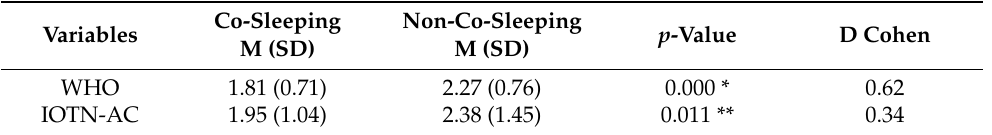
Table 4. Comparison of clinical variables of malocclusion (IOTN-AC and WHO) in co-sleeping ( n = 130) and non-co-sleeping ( n = 91)